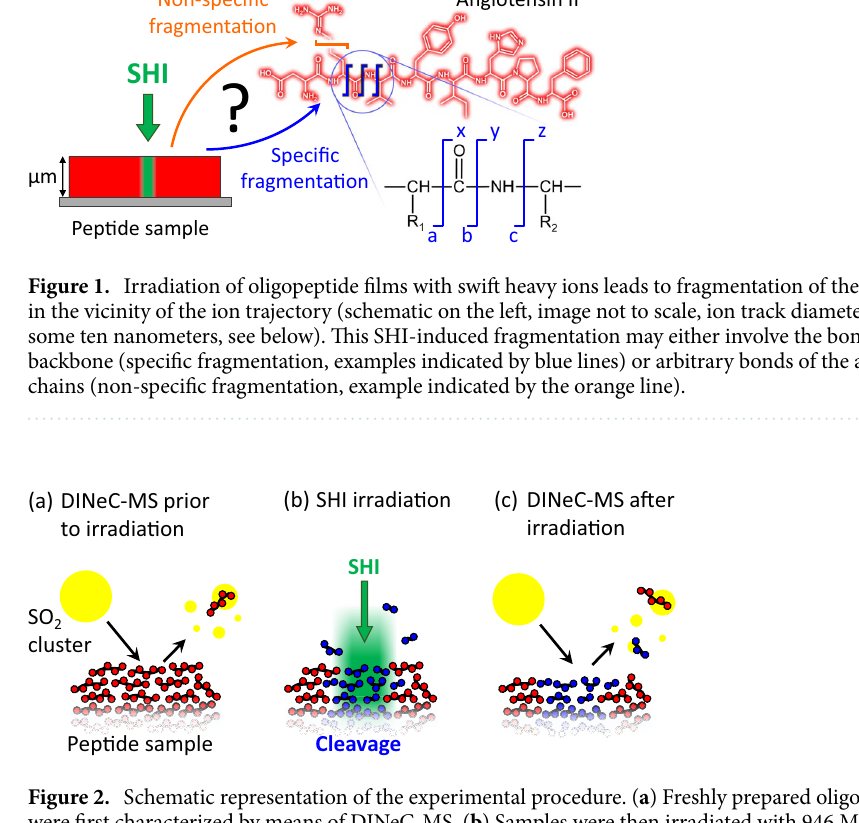
Figure 2. Schematic representation of the experimental procedure. ( a ) Freshly prepared oligopeptide films were first characterized by means of DINeC-MS. ( b ) Samples were then irradiated with 946 MeV Au ions at GSI, leading to cleavage of covalent bonds in the molecules. ( c ) Subsequent DINeC analysis of the irradiated samples reveals SHI-induced fragments which remain in the sample and have not been sputtered during SHI-irradiation. Schematics are not to